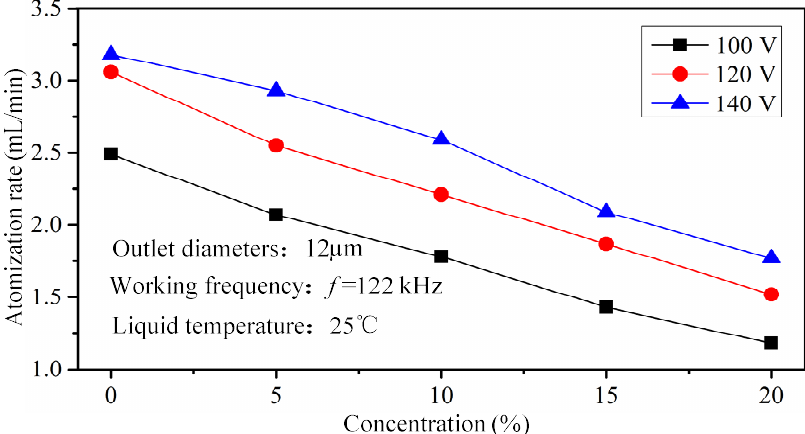
Table 6. Atomization rates at different concentrations of NaCl solution.